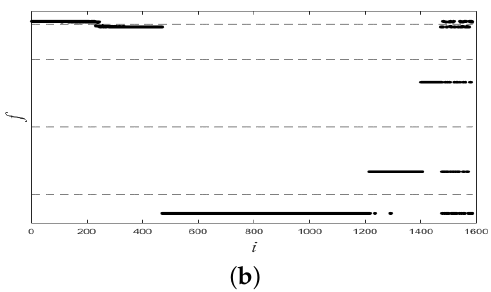
Figure 6. Plots of f for two synthetic datasets. ( a ) Dataset 1. ( b ) Dataset 2.